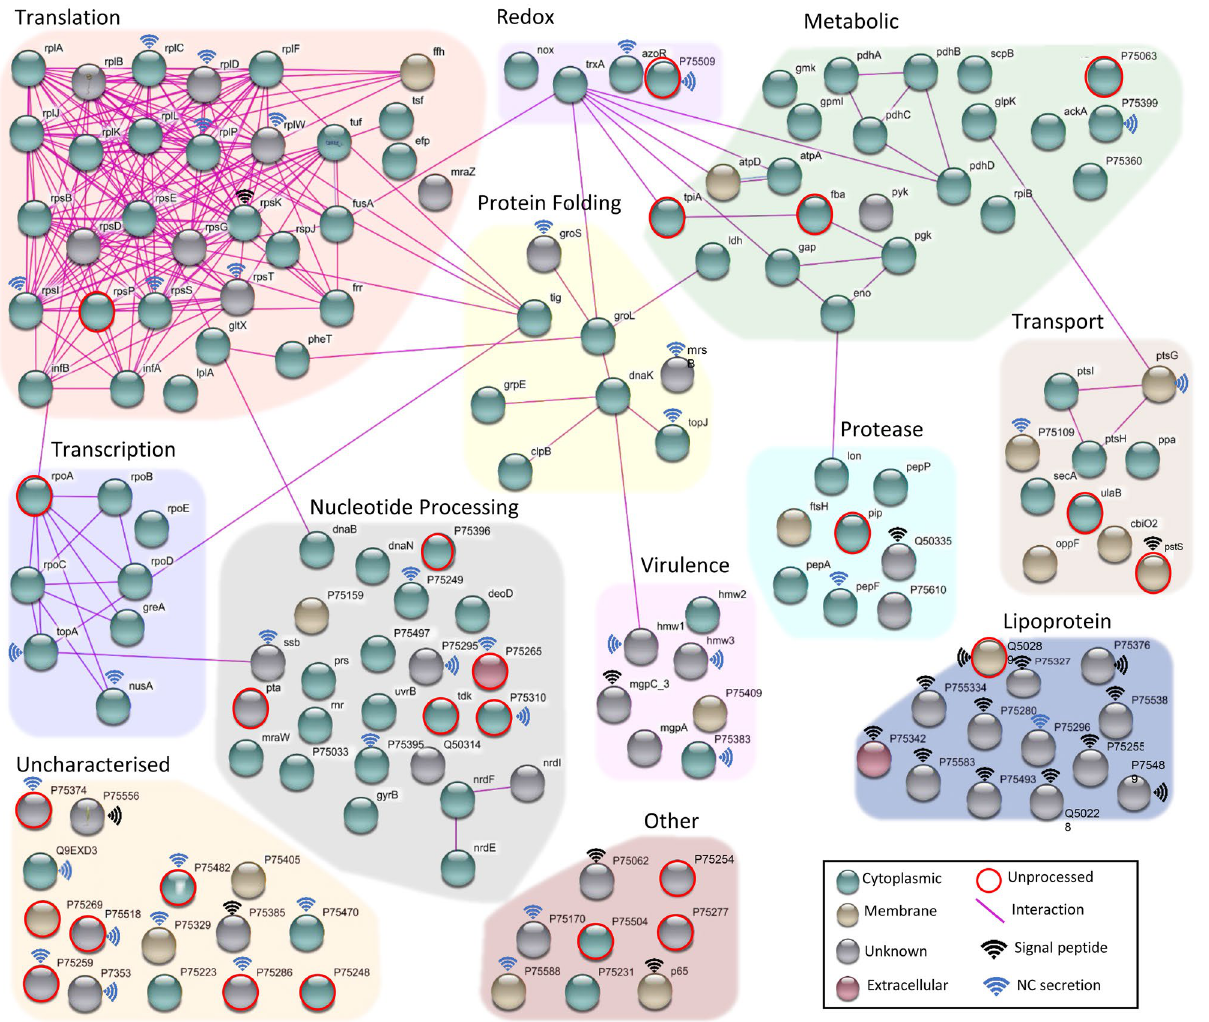
Figure 2. Interaction map of all proteins identified on the surface of Mycoplasma pneumoniae , grouped by gene ontology. Proteins with known interactions provided by STRING, are indicated by connecting lines, representing possible protein networks on the cellular surface. Proteins are coloured by their predicted cellular location: green (cytoplasm), brown (membrane), grey (unknown), red (extracellular). Proteins with signal icons either contained a signal peptide (black signal icon) or were found to be non-classically secreted (blue signal icon). Proteins indicated with a red circle were not found to be processed in our N-terminome, all other proteins were found with endo-proteolytic processing